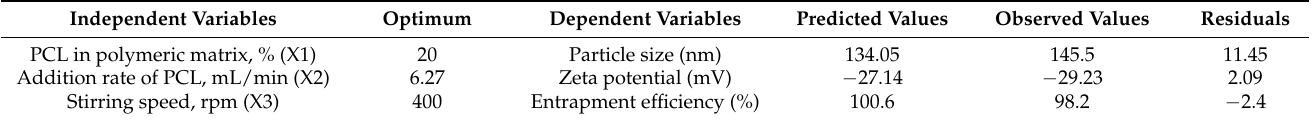
Table 4. The optimum levels for the independent variables and values of the studied dependent variables.